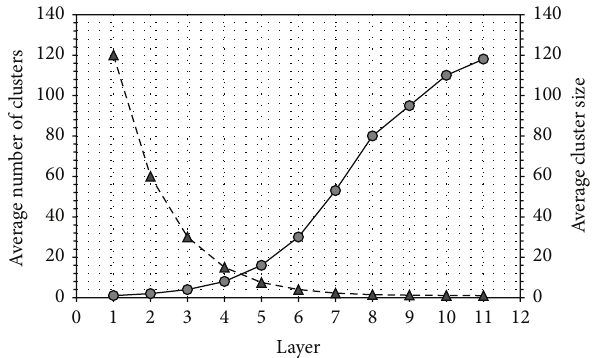
Figure 15: History of the number of clusters in each layer.